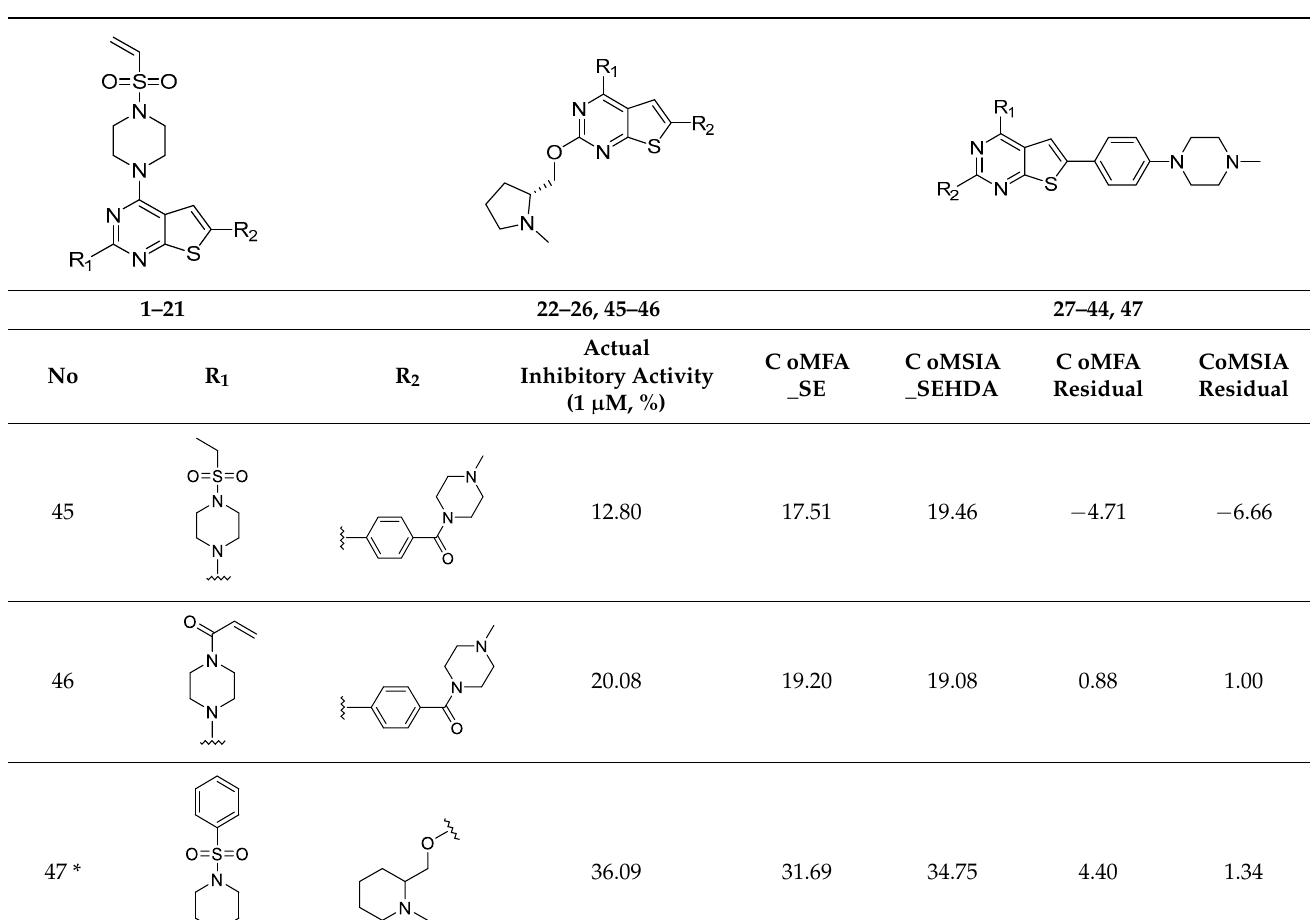
Table 6. Chemical structures and inhibitory activity values of thieno-pyrimidine derivatives. Table 6. Cont.